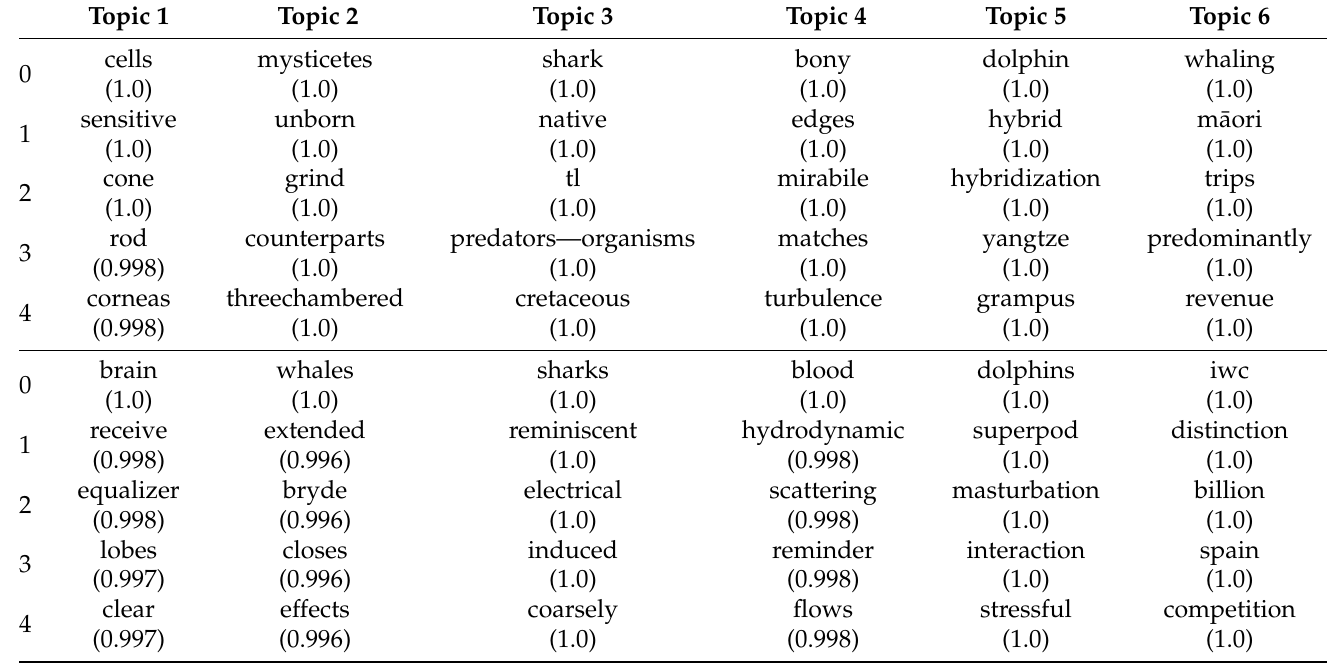
Table A7. For the most significant two words per topic, the four nearest neighbors based on cosine similarity are